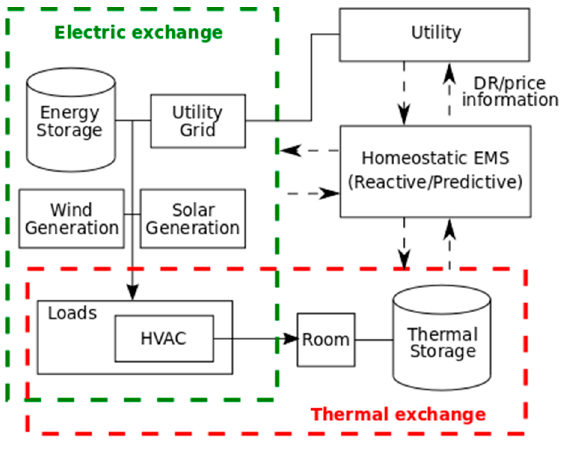
Figure 2. Energy fluxes and control.